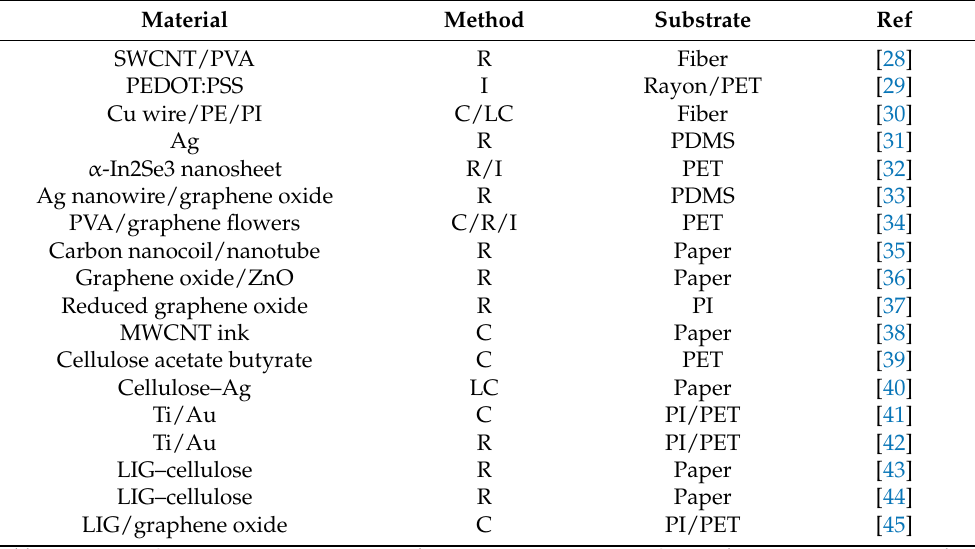
Table 1. Moisture sensing strategies based on interdigitated sensors deposited on thin flexible films.